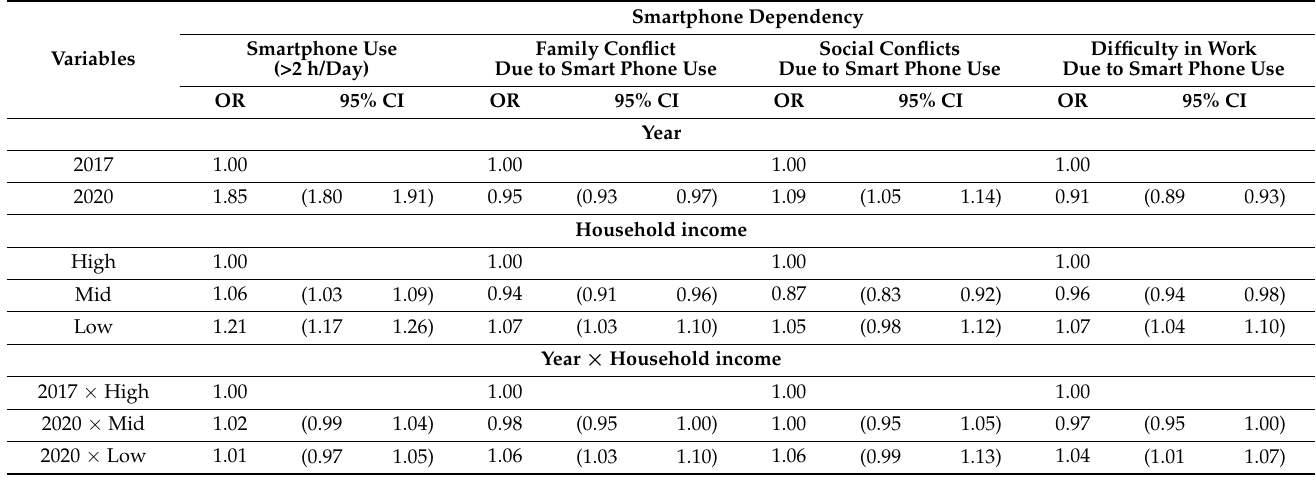
Table 3. Results of interaction analysis stratified by year and household income.